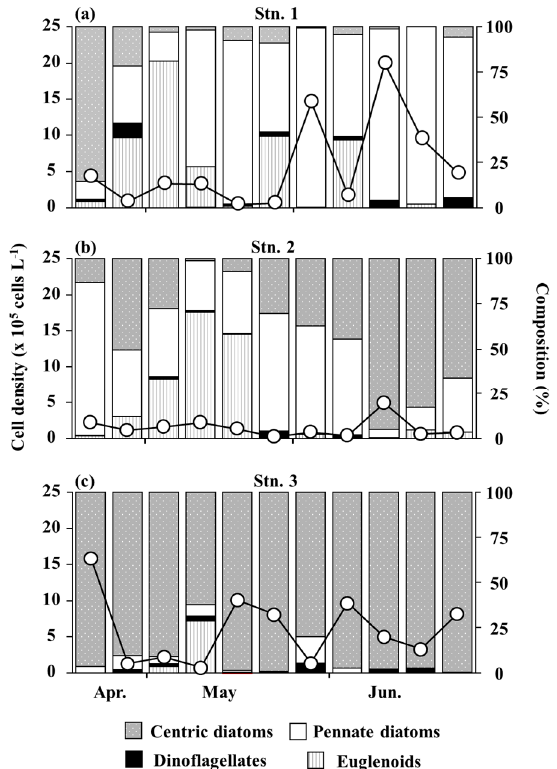
Figure 3. Temporal changes of cell densities ( ○ ) and phytoplankton communities in composition (histograms) in the surface water collected at Stn. 1 ( a ), Stn. 2 ( b ), and Stn. 3 ( c ). At Stn. 2, the total cell numbers of phytoplankton fluctuated within a relatively low- density range at 2.7 × 10 4 –5.0 × 10 5 cells L − 1 (Figure 3b). The taxonomic composition varied greatly. The centric diatoms predominated (13–50%) in April, and then the ratios of Eu- glenoid and pennate diatoms increased in May (42–97%). The appearance of the genus